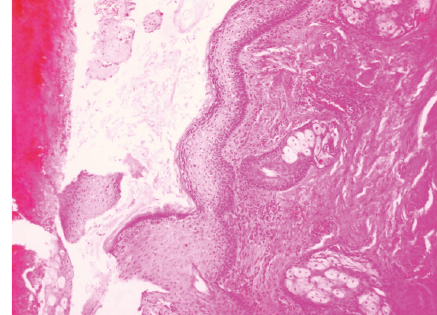
Figure 1: Cystic cavity lined by keratinized stratified squamous epithelium and the cavity filled with anucleate squames and keratin.